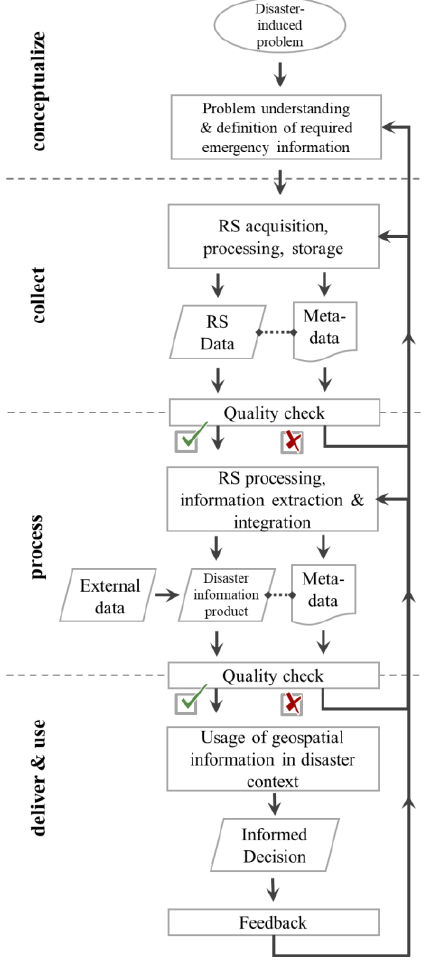
Figure 2: The RS information production process where delivery of RS data products is controlled by quality checks enhanced with data quality information stored in the metadata. The application Figure 1: Dependencies between the RS lifecycle, data sources context (disaster response) serves as an illustration, the process and RS Quality Dimensions. is otherwise considered